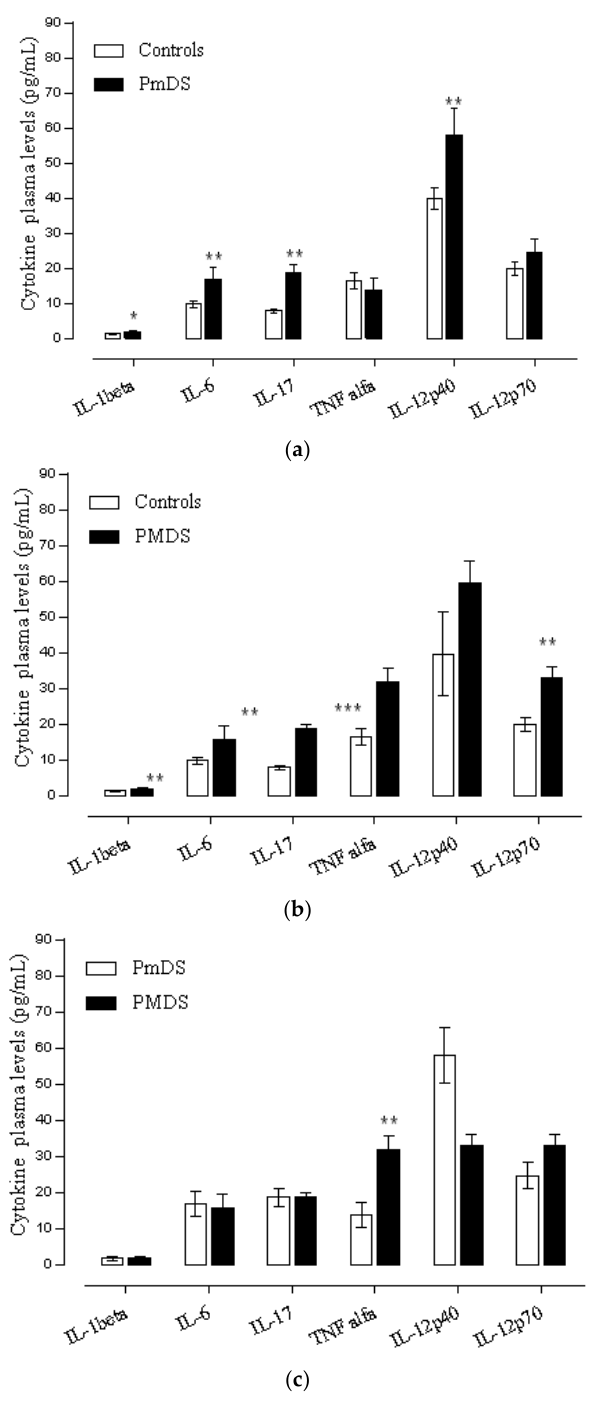
Figure 4. ( a ) Plasma cytokines level in autistic patients with mild disease severity and controls. Data are shown as median ±SEM. Significant differences, * p < 0.05, ** p < 0.001. t -Student test, PmDS (Mild disease severity); ( b ) Plasma cytokines level in autistic patients with moderate disease severity and controls. Data are shown as median ± SEM. Significant differences, * p < 0.05, ** p < 0.001. t -Student test, PMDS (Moderate disease severity); ( c ) Plasma cytokines level in autistic patients with mild and moderate disease severity. Data are shown as median ± SEM. Significant differences, * p < 0.05. t -Student test, (PmDS vs. PMDS): Mild vs. Moderate disease severity.